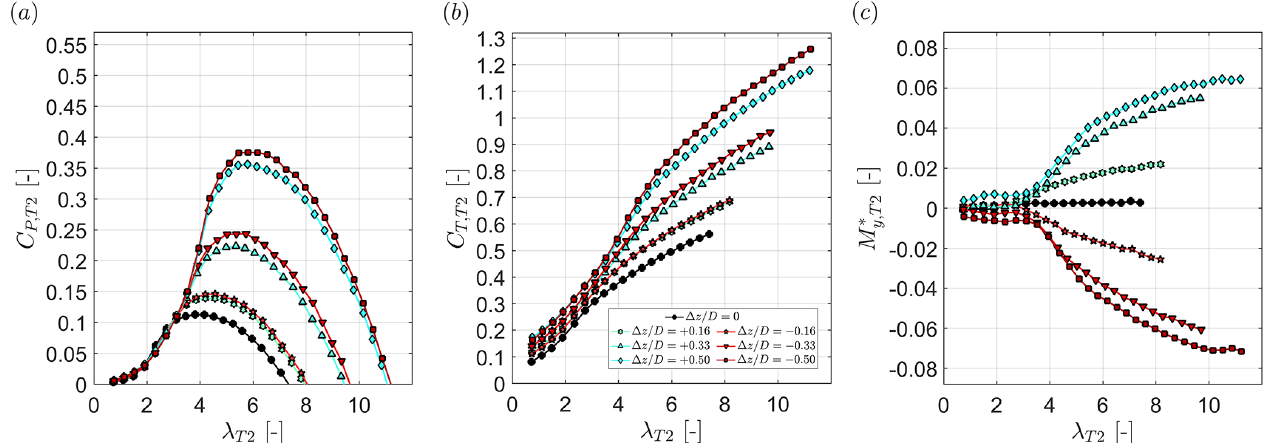
Figure 7. Downstream turbine (a) power coefficient, (b) thrust coefficient and (c) normalized yaw moment as a function of its tip speed ratio λ T2 for different lateral offset positions (cid:49)z/D . The upstream turbine yaw angle is kept constant at γ T1 = 0 ◦ . The downstream turbine T2 is located at x/D = 3. The turbines are exposed to inflow